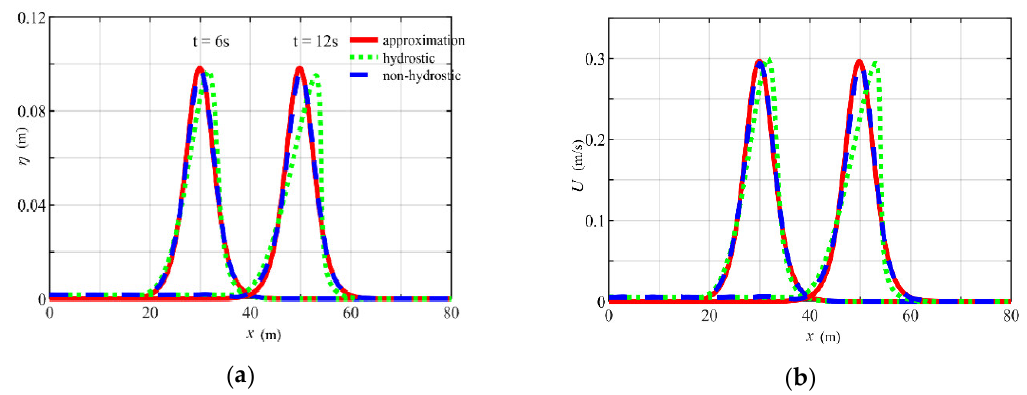
Figure 1. Comparison of approximation and model results of ( a ) free-surface and ( b ) horizontal velocity at t = 6 and 12 s, respectively.